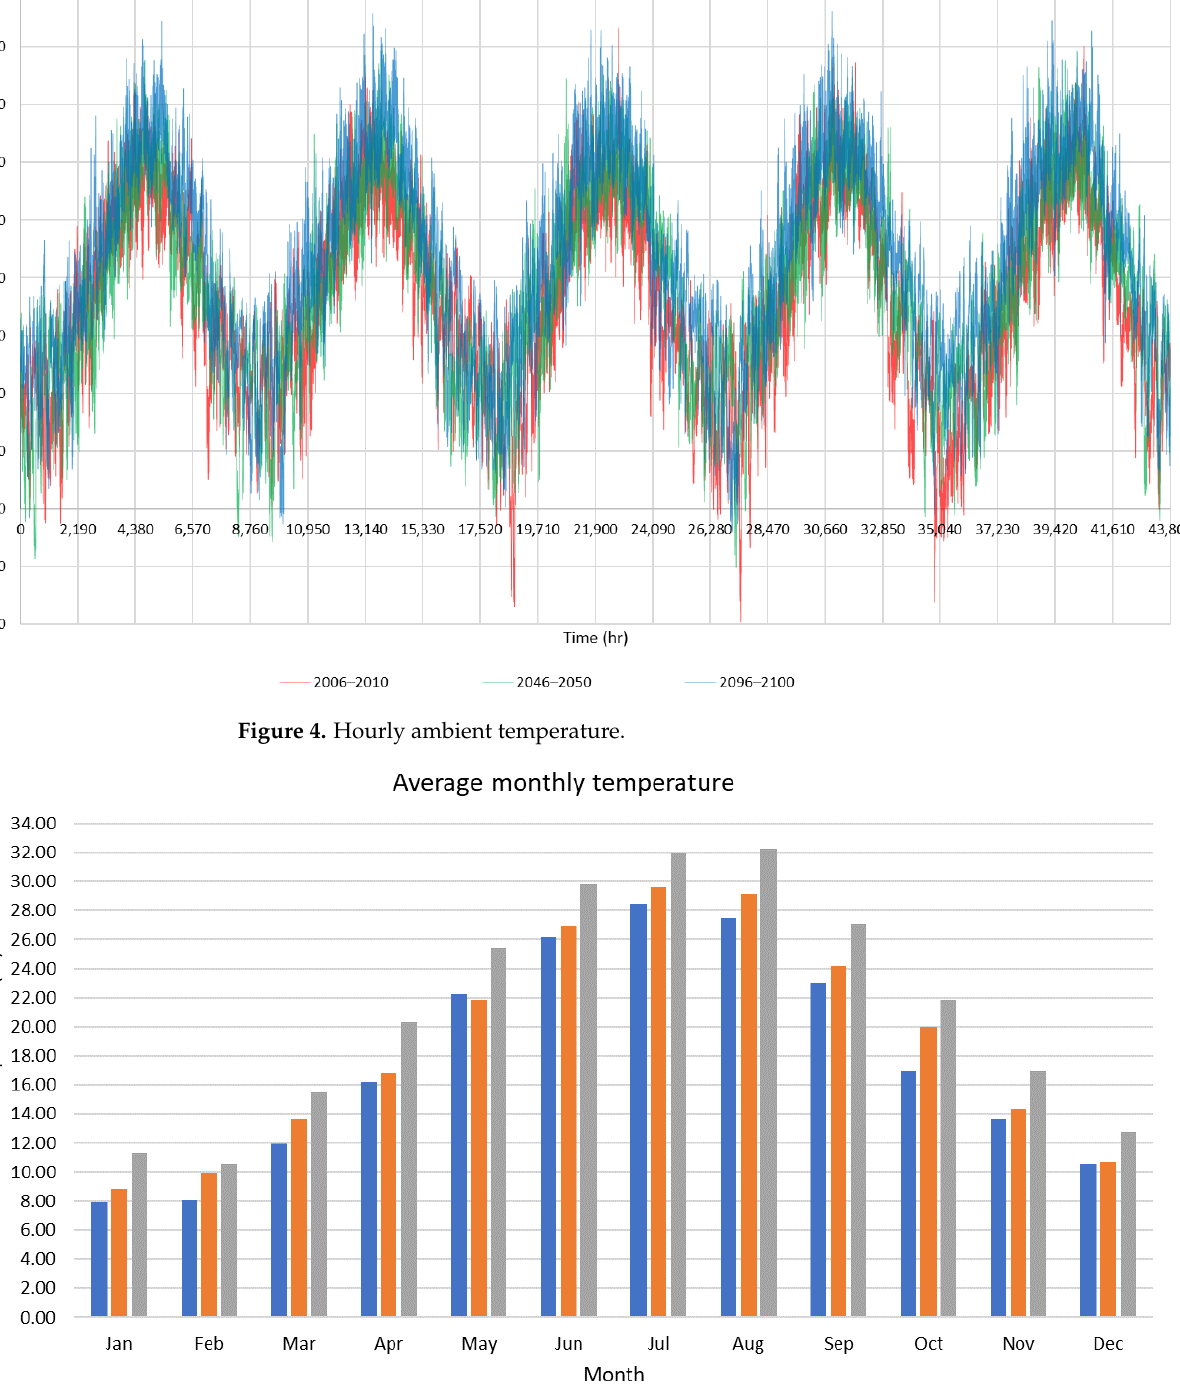
Figure 6. Hourly energy demand for HVAC purposes . It is noticeable that there was a continuous upward trend in terms of ambient temperature dependent on the RCP8.5 forcing scenario selected. The increase in